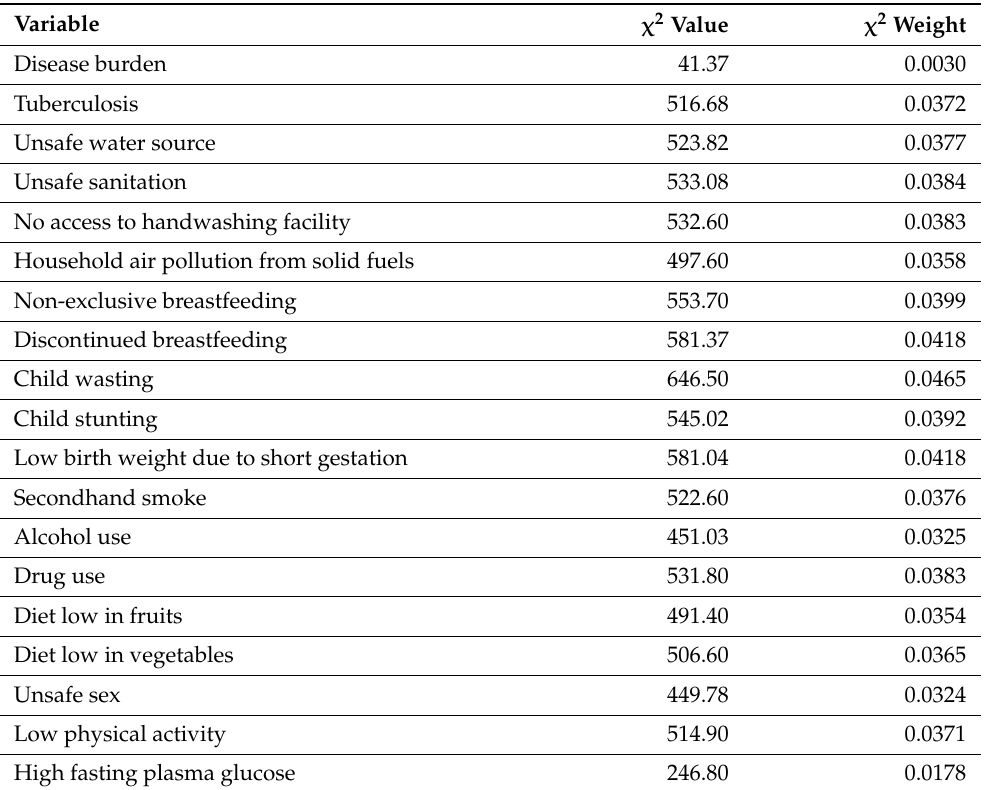
Table 3. Results of Chi-square